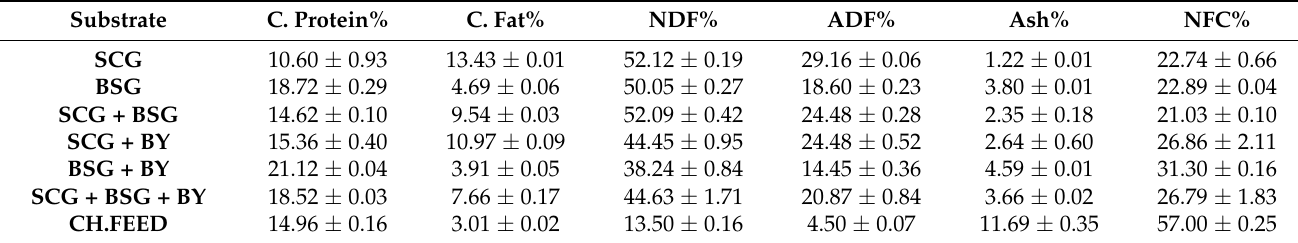
Table 1. Chemical properties of spent coffee ground, brewer’s spent grain, brewer’s yeast with their combinations used in the current study (mean ± standard error; n = 3). Substrate C.